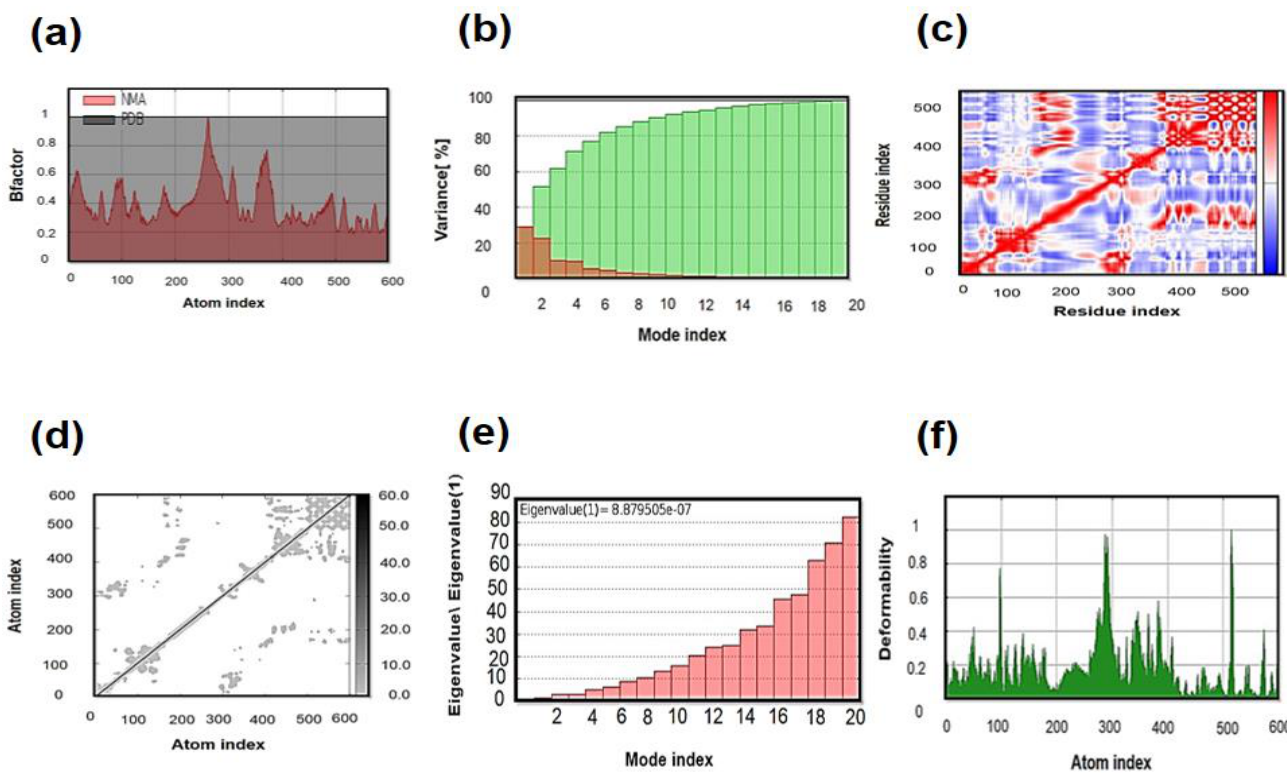
Figure 6. MD simulation of the MEV refined structure: ( a ) B-factor, ( b ) variance, ( c ) covariance matrix, ( d ) elastic network analysis, ( e ) eigenvalue and ( f ) deformability .